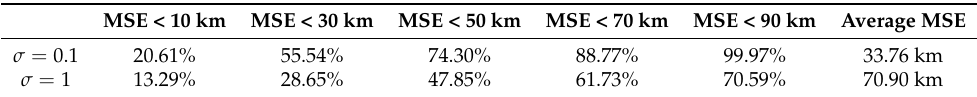
Table 2. Percentage of areas with different MSEs using the second set of six fixed receivers deployment under σ = 0.1 and σ = 1.